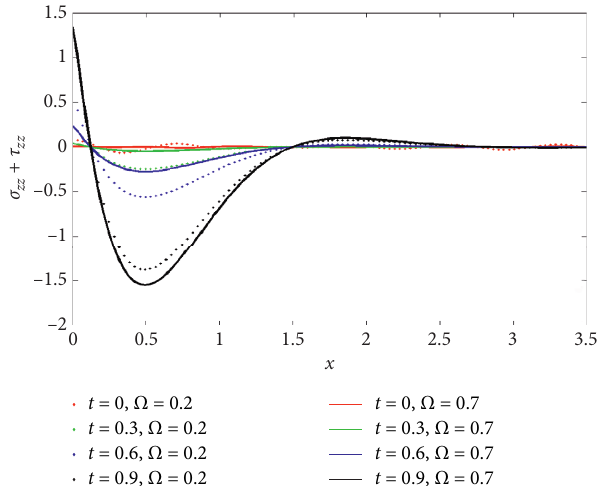
Figure 24: Stress τ rotation.